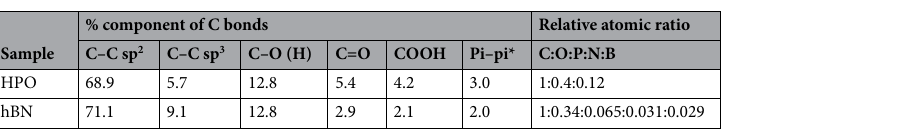
Figure 2. ( a ) Survey Scans of the hBN and HPO samples. ( b , c ) Deconvoluted C1 s XPS peaks of the hBN and HPO samples, respectively.